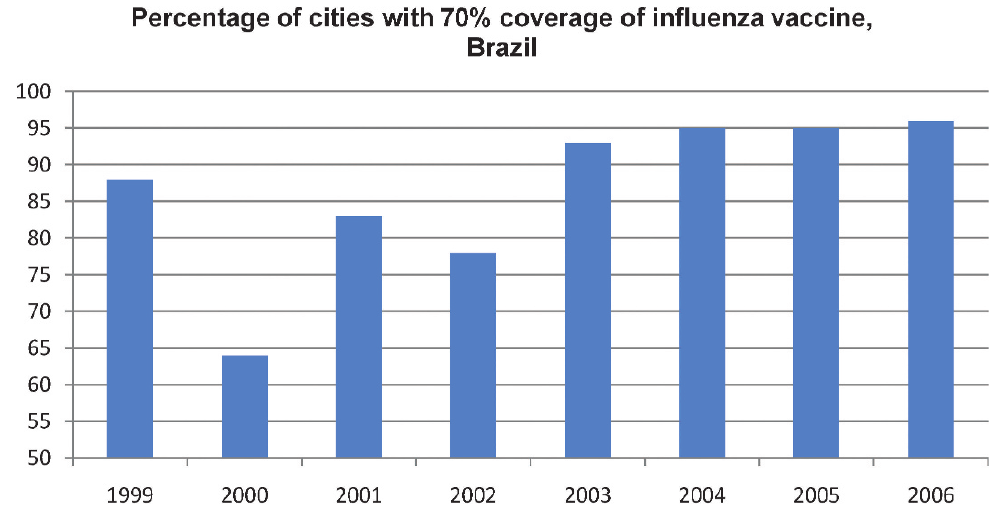
Figure 2 - Percentage of Brazilian cities with at least 70% influenza vaccine coverage from 1999 through 2006. Adapted from the National Influenza Immunization Campaign Targeting Older Persons Technical Report, Brazil, Ministry of Health, 2007.